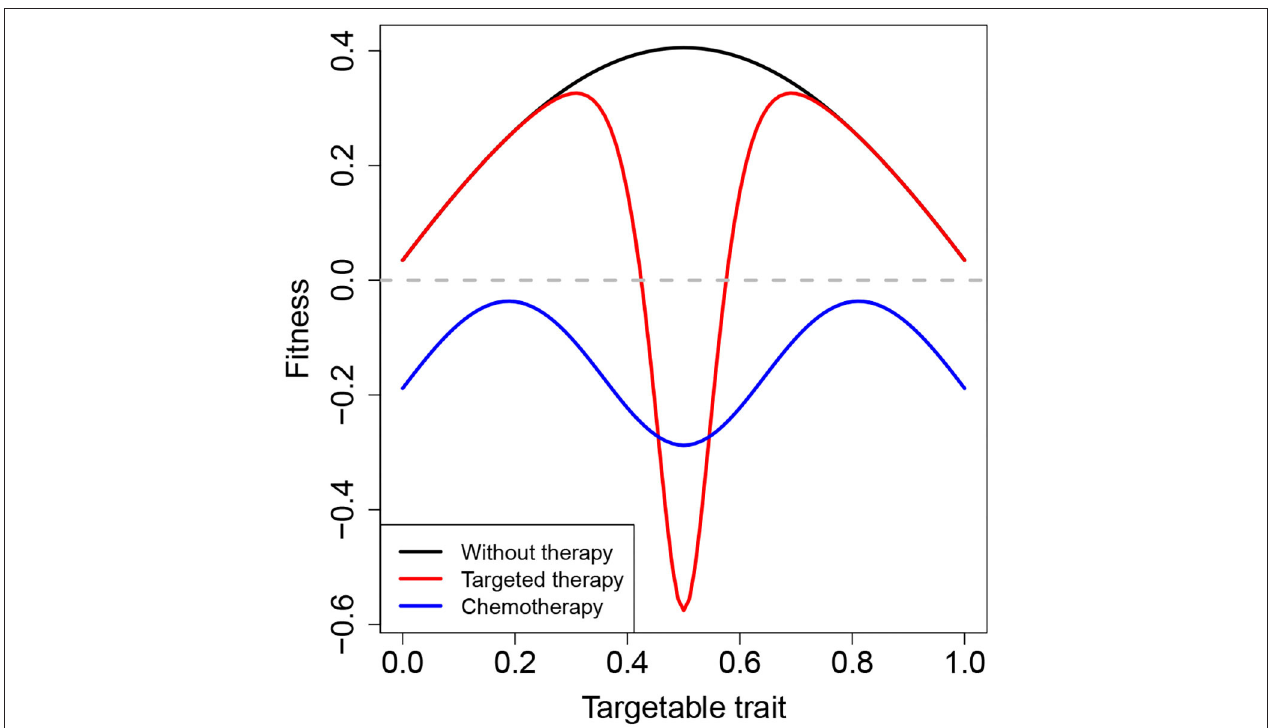
FIGURE 3 | Hypothetical fitness landscape in response to therapy. The black curve represents the fitness of the cancer cells in the absence of therapy, which is maximized for an intermediate value of some pathway trait. Targeted therapy, represented by the red curve, greatly diminishes the fitness of cancer cells with intermediate trait values. However, in so doing, it leaves room for cancer cells with more extreme trait values to survive. The blue curve depicts the effects of chemotherapy, which broadly reduces the fitness of all cells below a critical threshold, although not as dramatically as the targeted therapy on cells with intermediate trait